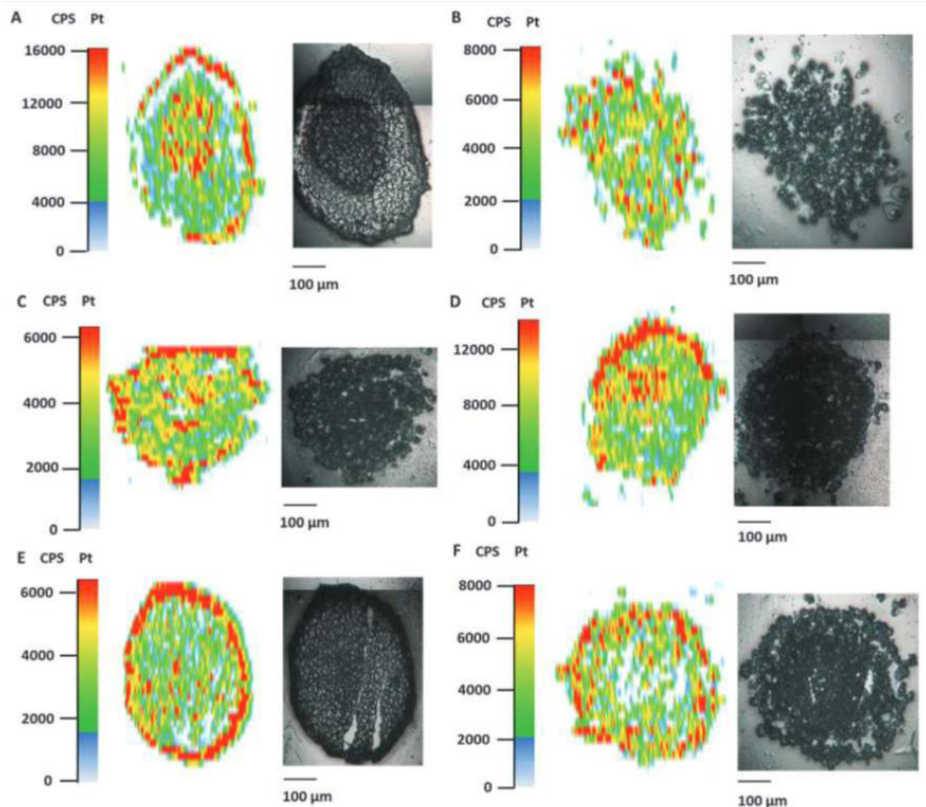
Figure 1. Platinum distribution in cryo-sections of HCT116 and CH1/PA-1 tumor spheroids after treatment with Pt-complexes (1 – 5 µM) measured by LA-ICP-MS. Reprinted with permission from Ref. [21], Copy right year: 2016, copyright owner: Oxford University Press, ( A ) HCT116 tumor spheroids treated with satraplatin, ( B ) CH1/PA1 spheroids treated with satraplatin, ( C ) HCT116 tumor spheroids treated with new “Pt - compound 1”, ( D ) CH1/PA1 spheroids treated with new “Pt - compound 1”, ( E ) HCT116 tumor spheroids treated with new “Pt - compound 2”, ( F ) CH1/PA1 spheroids treated with new “Pt - compound 2”.